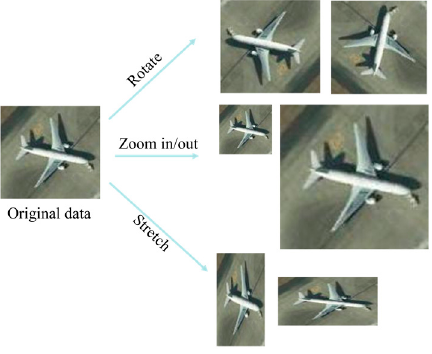
Figure 5. Data expansion in one target.